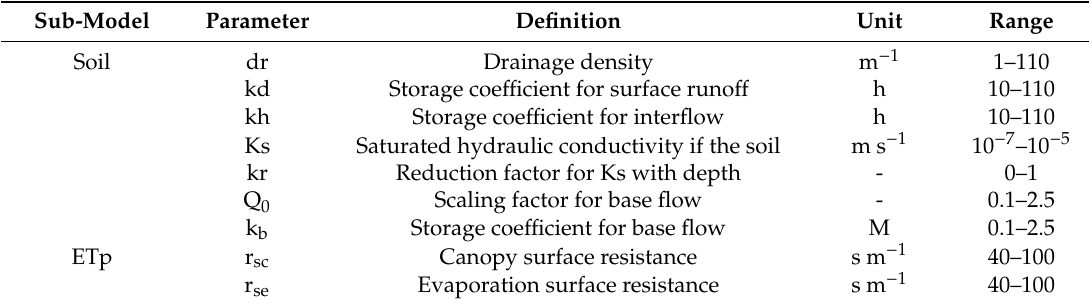
Table 2. The optimized water balance simulation model (WaSiM) soil and evapotranspiration